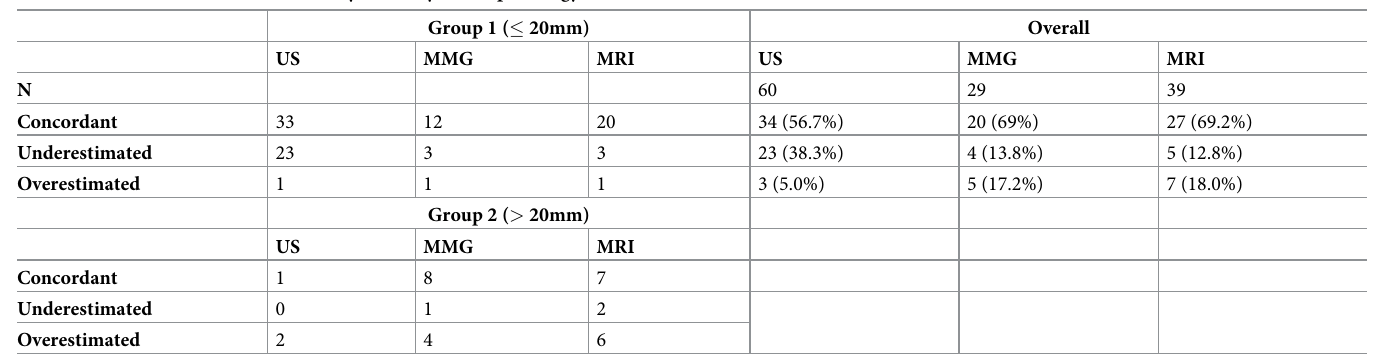
Table 4. Concordances of tumour size by modality versus pathology.